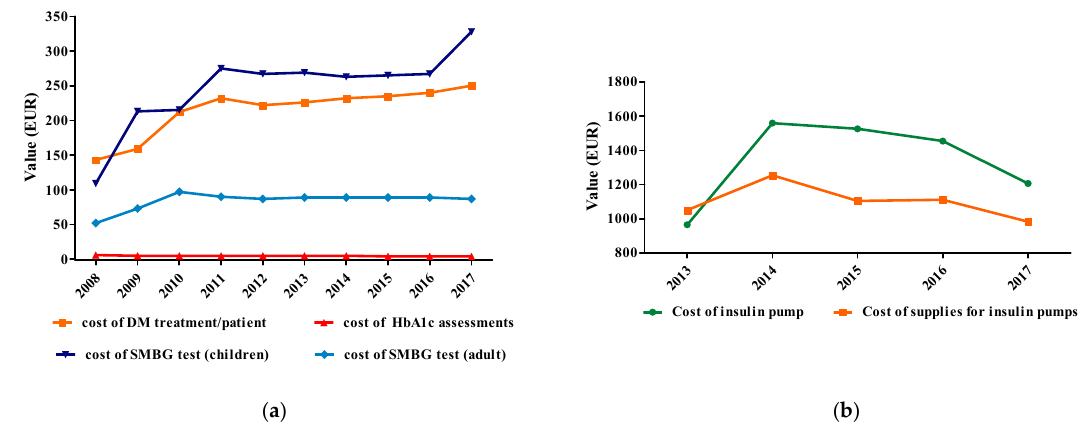
Figure 6. Efficiency indicators (EUR): ( a ) cost of DM treatment/patient/year (EUR), cost of HbA1c assessments (EUR), cost of SMBG test for children (EUR), cost of SMBG test for adult (EUR), ( b ) cost of insulin pump (EUR), cost of supplies for insulin pumps (EUR).